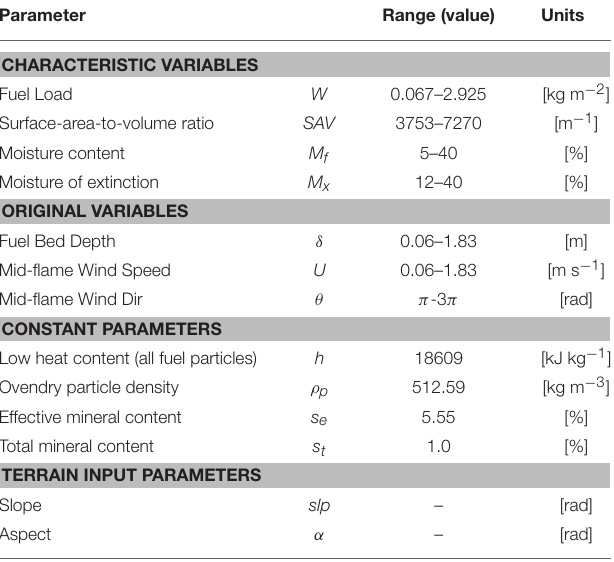
TABLE 3 | Summary of the proposed fuel model variables, ranges, and constant